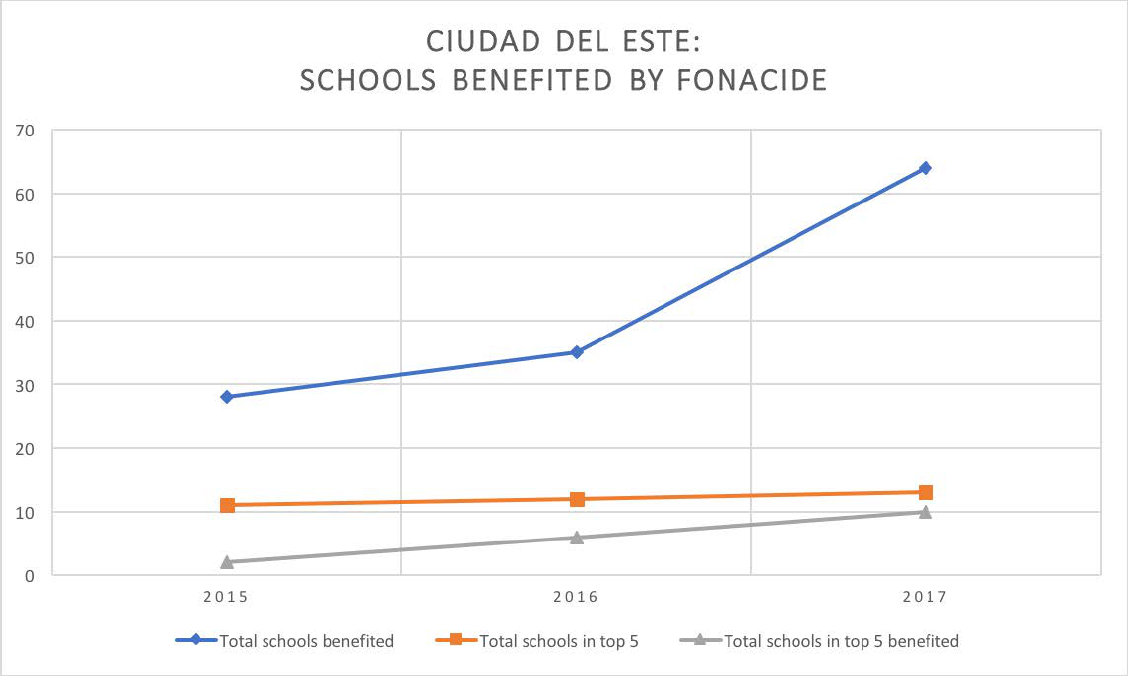
Source: Author’s elaboration with datasets provided by Reaccion